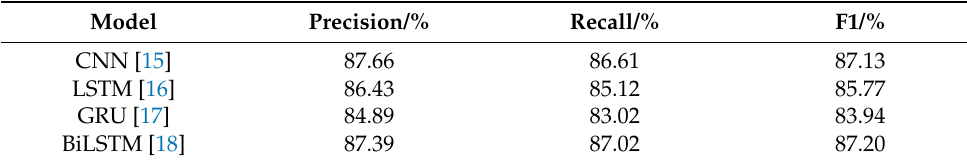
Table 4. Single model comparison results.